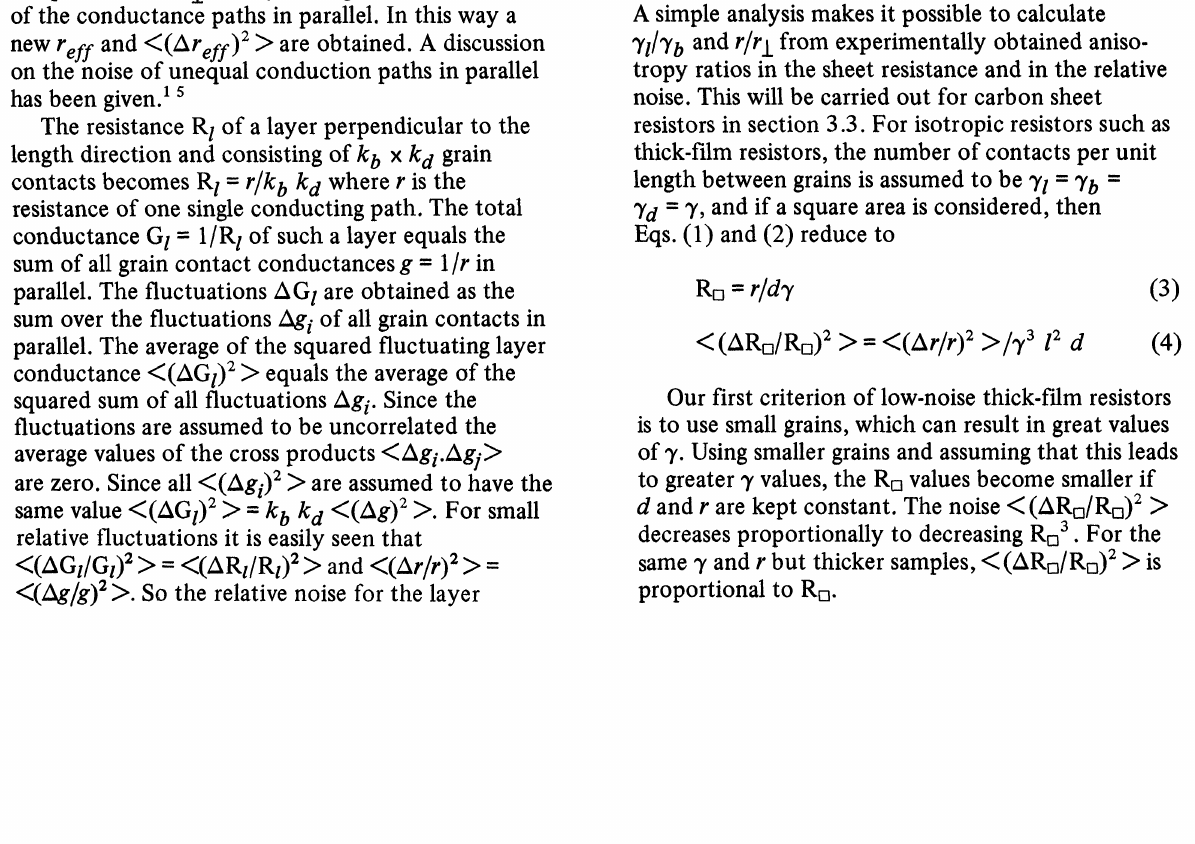
FIGURE Simple model for a thick-film resistor. linking branches are uncorrelated, (v) the resistance r of the type represented in Figure by the area labelled I are assumed to carry no net